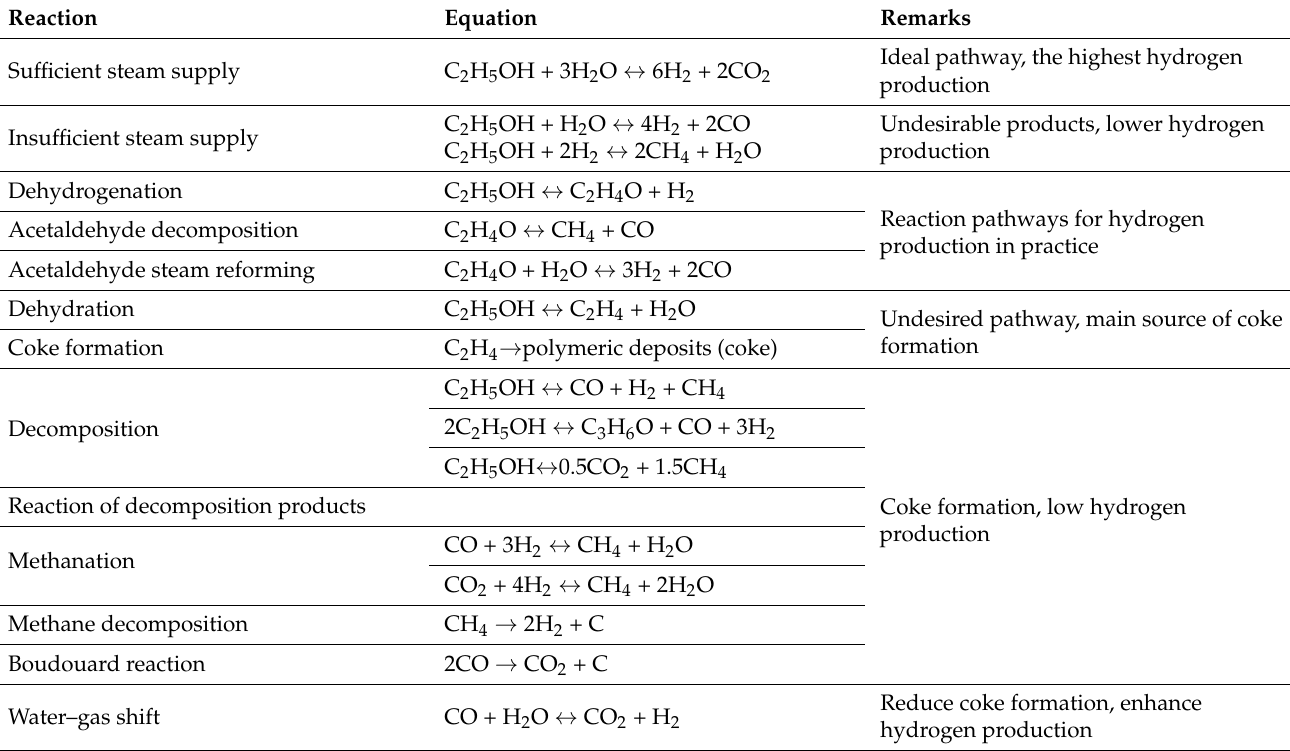
Table 2. Main pathways involved in ethanol steam reforming